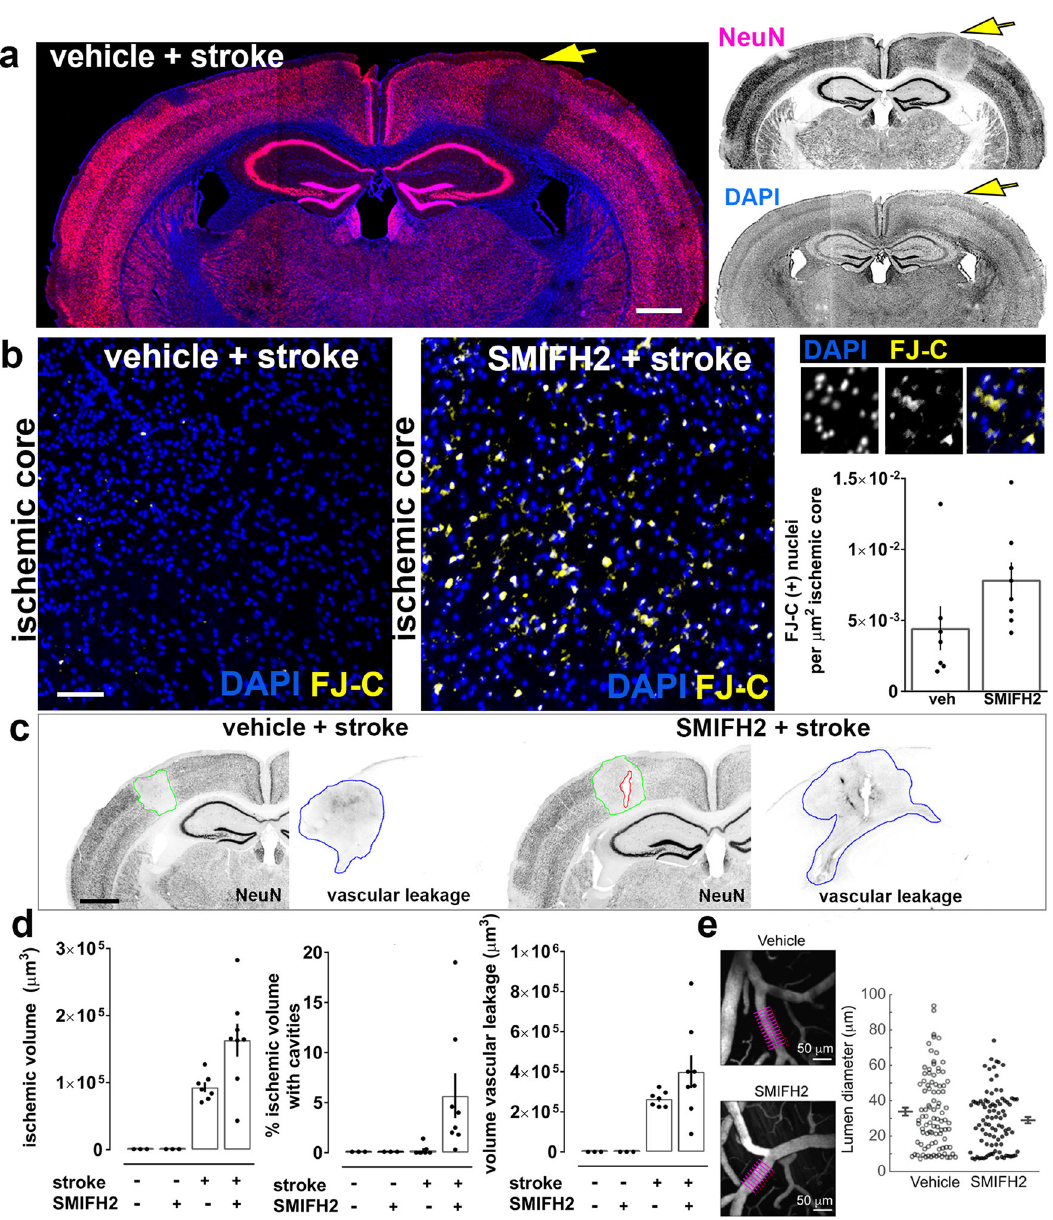
Fig. 7 | Formininhibitionenhancesstroke-inducedcelldeath invivo.a Coronal mouse brain section showing reduced NeuN immunoreactivity within the infarct region (yellow arrow) 4h post-stroke. Scale bar, 850 µ m. b SMIFH2 increases early cell death as shown in representative regions of cortical ischemic core. Enlarged panels at right illustrate somatic FluoroJade-C (FJ-C) colocalization with nuclear DAPI staining. Quanti fi cation of the density of FJ-C-positive (+) soma within the ischemic core region. n =7 animals (veh+stroke); n =8 animals (SMIFH2+stroke); Mann – Whitney test, two-tailed p =0.0401; Scale bar: 70 µ m. c Images of brain sections stained for the neuronal marker NeuN and for IgG to assess vascular leakage following stroke. Scale bars, 800 µ m. d Quanti fi cation of infarct volume (based on NeuN signal loss), fraction of ischemic volume containing cavitations (holes in the brain parenchema), and vascular leakage (based on volume of IgG signal). n =3 animals (veh./no stroke), n =3 animals (SMIFH2/no stroke), n =7 ani- mals (veh+stroke), n =8 animals (SMIFH2+stroke). Ischemic volume: Kruskal – Wallis one-way ANOVA ( p =0.0015), with Dunn ’ s post hoc multiple